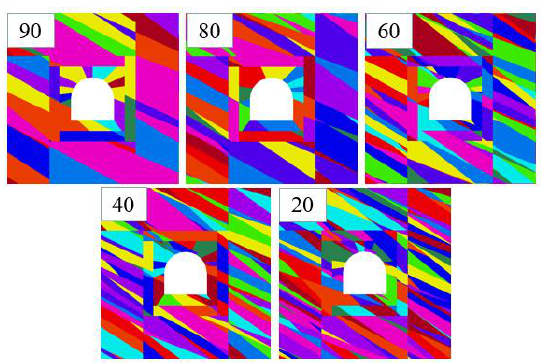
Figure 8. Numerical model of equivalent rock mass with different GSI values.